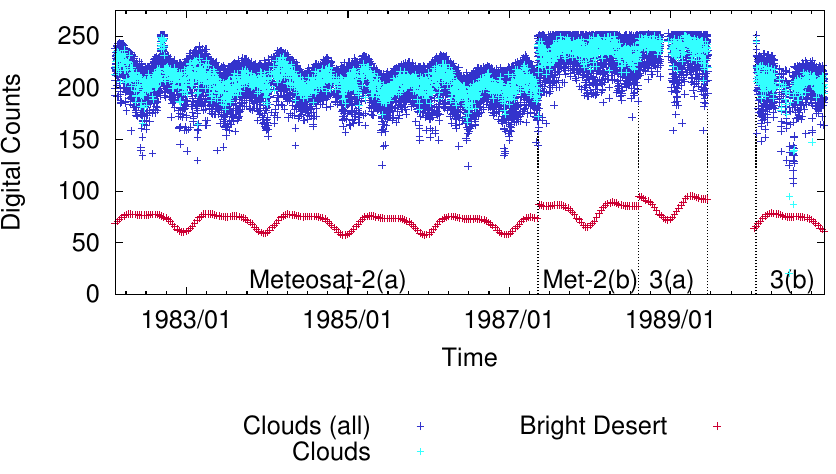
Figure 5. The Meteosat-2 and -3 convective cloudy and bright desert time series expressed in DC. In dark blue, all 6 convective cloudy values are shown per day, in light blue, the 6 convective cloudy values are averaged out per day, and in red at the bottom, the values of the 37 bright desert sites are averaged out every 10